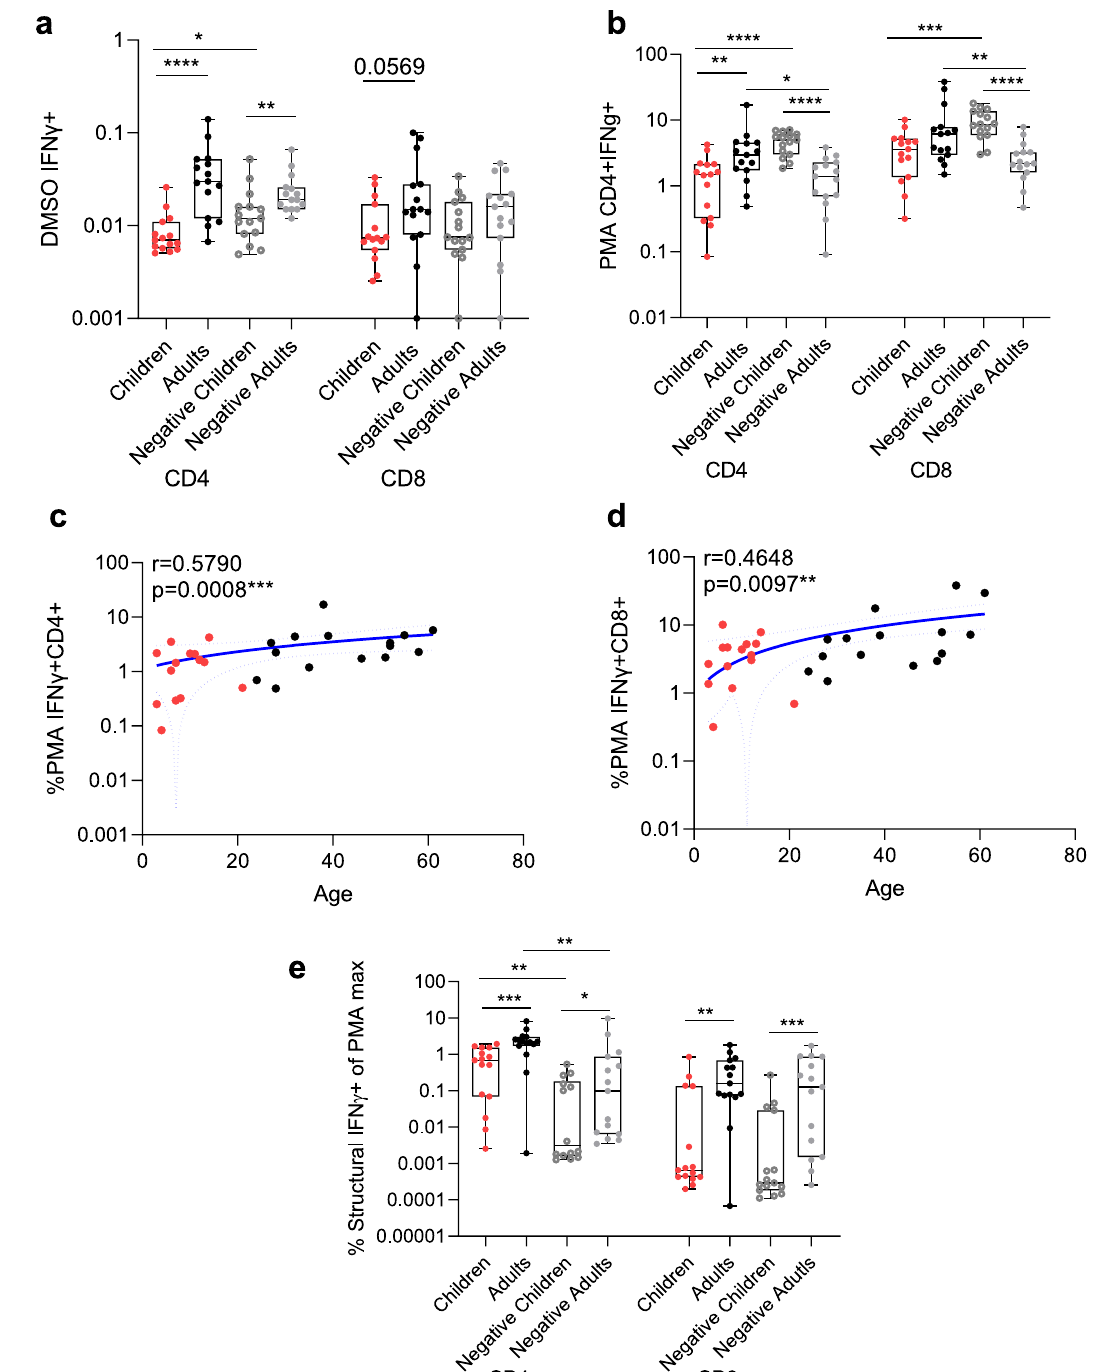
Fig. 3 Non-speci fi c T cell responses increase with age in infected donors. CD4 + and CD8 + T cell responses for ( a ) background (by DMSO stimulation) and ( b ) maximum (by PMA/Ionomycin stimulation) in children ( n = 15), adults ( n = 15) from convalescent/ memory time points (mean ± stdev 34 ± 11, range: 14 – 57 days post symptom onset), and uninfected negative children ( n = 15) and adult ( n = 15) controls. Comparisons were made by Mann – Whitney test where ** p < 0.01, *** p < 0.001, **** p < 0.0001. Correlation of age with CD4 + ( c ) and CD8 + ( d ) T cell responses by PMA/ionomycin stimulation. Two- sided Spearman ’ s test was used to calculate r values, and statistical signi fi cance is displayed as *** p < 0.001. c , d Blue lines of linear regression represent the overall trend with dotted lines showing 95% con fi dence intervals. Black dotted lines represent the limit of detection (IFN γ of CD4 + = 0.00009% IFN γ of CD8 + = 0.00003%). e The structural peptide pool response for CD4 + and CD8 + T cells in adults and children (from Fig. 1g) normalised to a paired maximum IFN γ production from ( b ) PMA/ionomycin stimulation. Comparisons similarly made by Two-sided Mann – Whitney test where * p < 0.05, ** p < 0.01, ***p<0001. ( a , b , e ) Data is representative of individual values with box and whiskers plots showing the median, upper and lower quartiles, and minimum and maximum. ( a ) * p = 0.0463, ** p = 0.0054, **** p < 0.0001, (b) CD4 * p = 0.0164, ** p = 0.0086, **** p < 0.0001, CD8 ** p = 0.0057, *** p = 0.0002, **** p < 0.0001, ( e ) CD4 * p = 0.0259, ** p = 0.0011, 0.0049, *** p = 0.0005, CD8 ** p = 0.0049, *** p =